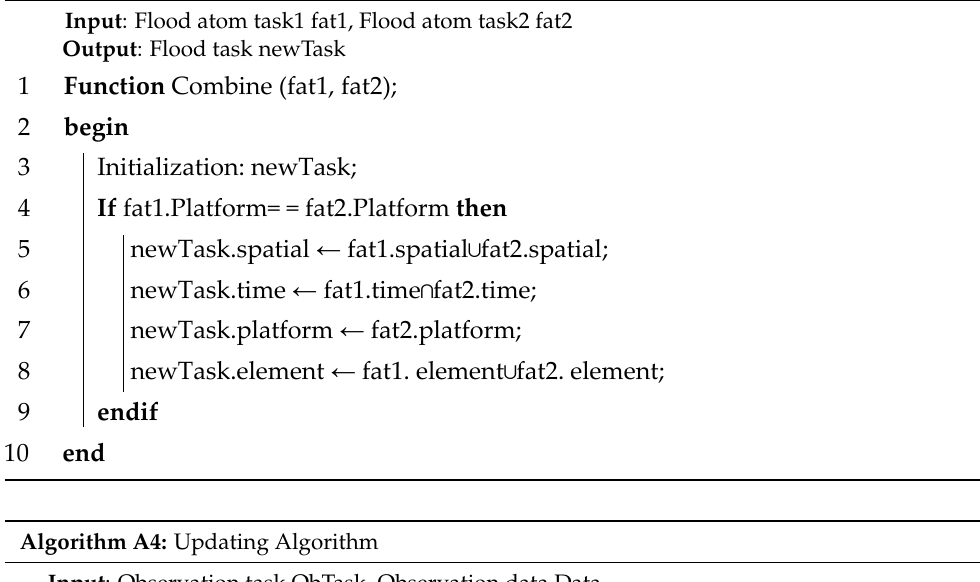
Algorithm A3: Combination Algorithm